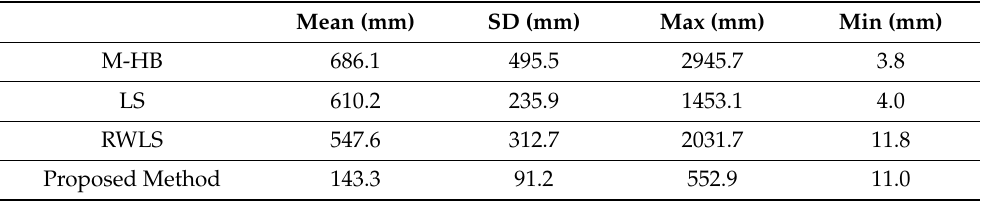
Table 5. Comparison of estimation error between the proposed method and previous methods for the circular path.